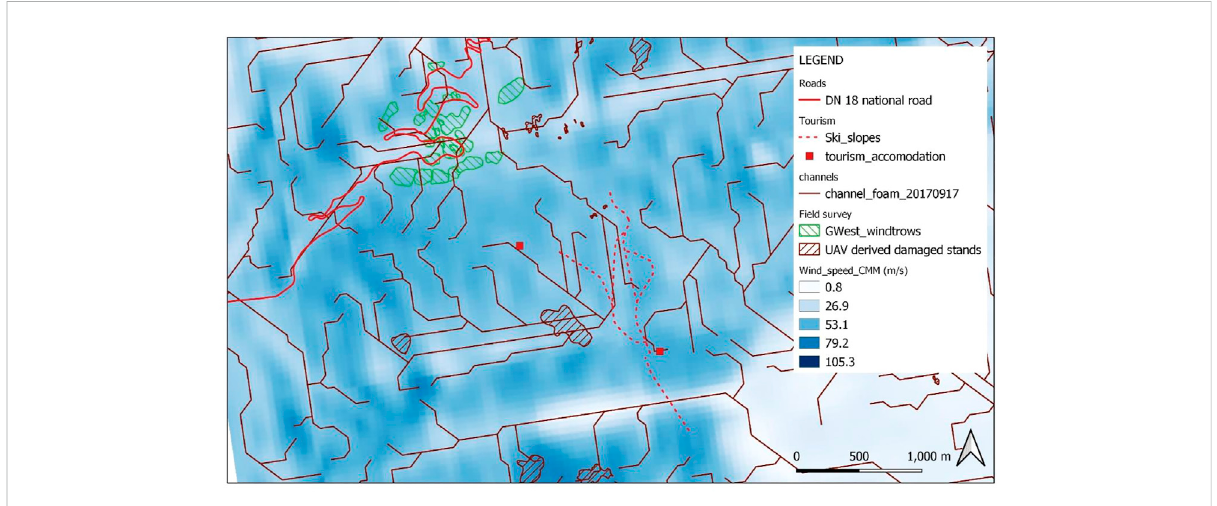
FIGURE 7 Initial CFD model of the storm on 17.09.2017, with channels derived from the WindNinja dataset, treated with tools from SAGA in QGIS 3.16.